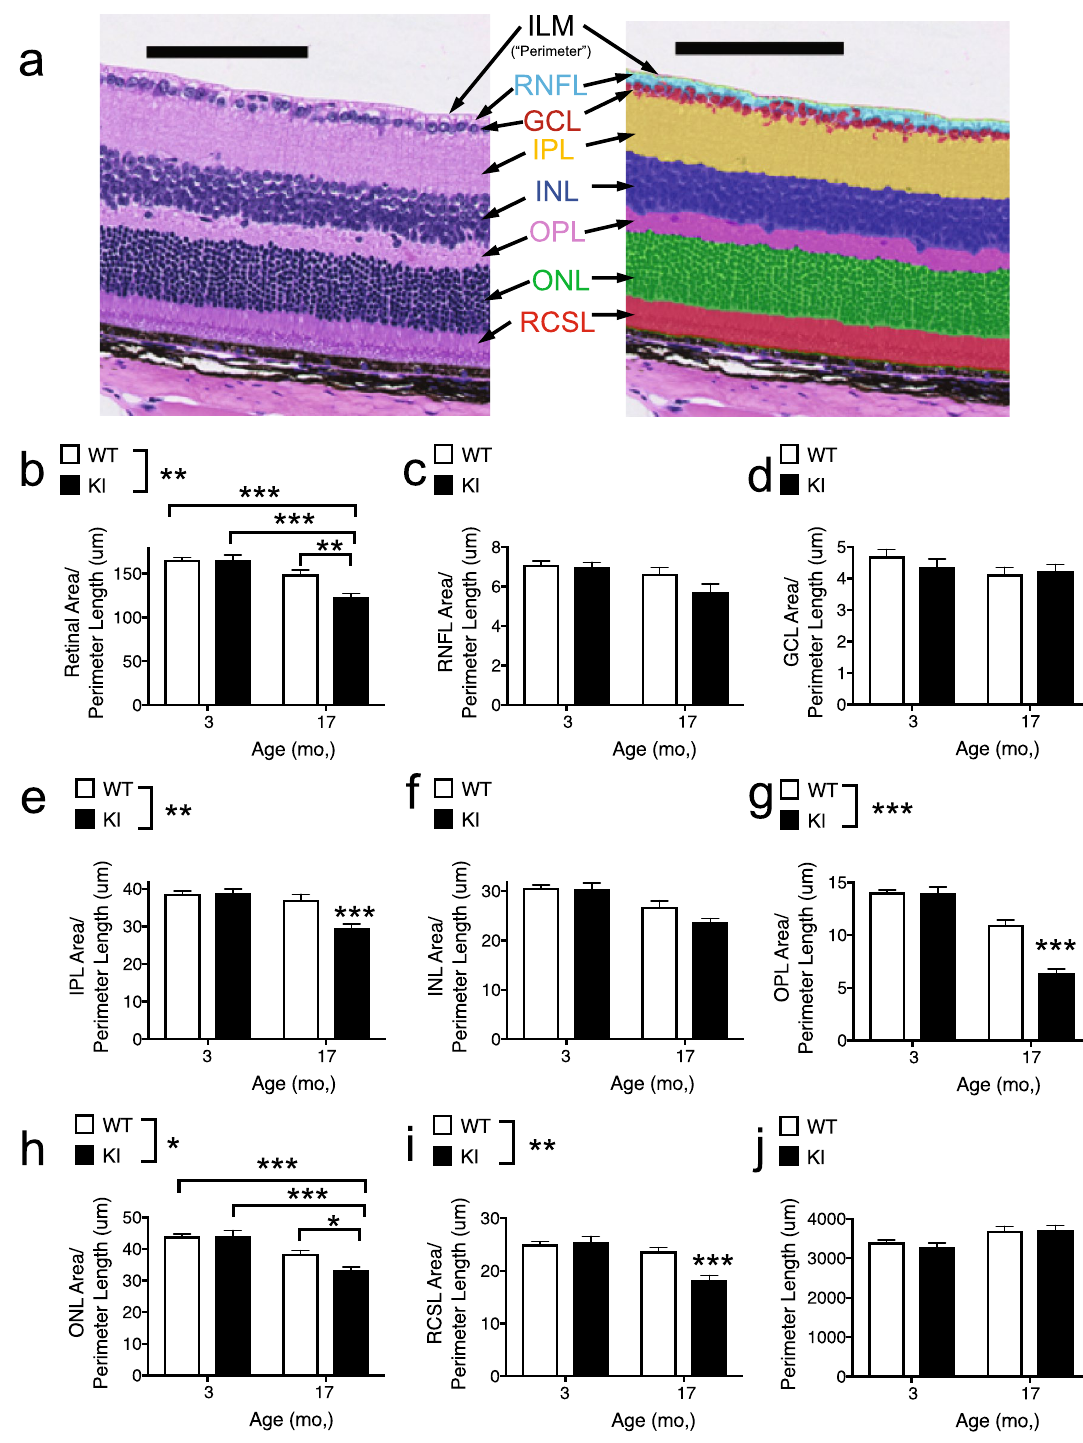
Figure 6. Retinal thinning in aged Gba KI mice. ( a ) Example H & E image from a young WT mouse (left) and the same image to which the algorithm for the quantification of retinal layers and sub layers has been applied (right). Area measures of retinal layers were normalized to the approximate length of the ILM which served as “perimeter”, thereby providing a proxy measure for thickness. ( b – j ) Area of the total retina ( b ) or the layers indicated ( c – i ) normalized to the perimeter length ( j ). Inner limiting membrane (ILM), retinal nerve fiber layer (RNFL), ganglion cell layer (GCL), inner plexiform layer (IPL), inner nuclear layer (INL), outer plexiform layer (OPL), outer nuclear layer (ONL), Rod and cone segments layer (RCSL). The scale bar denotes 100 µm. Asterisks denoting significance levels for main effects of genotype are indicated next to the genotype symbols above the graphs; those for post-hoc tests between individual genotype- and age- combinations are indicated within the graphs. Main effects of age are not indicated. * p < 0.05, ** p < 0.01, *** p < 0.001. Values are mean ±